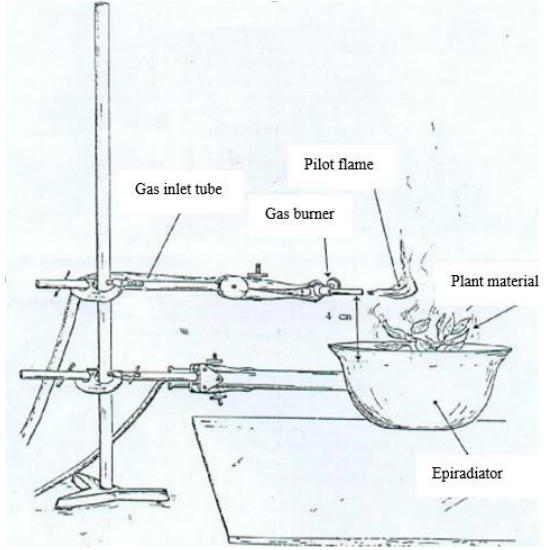
Figure 1. Epiradiator used for fuel species flammability testing and its illustrating schematic